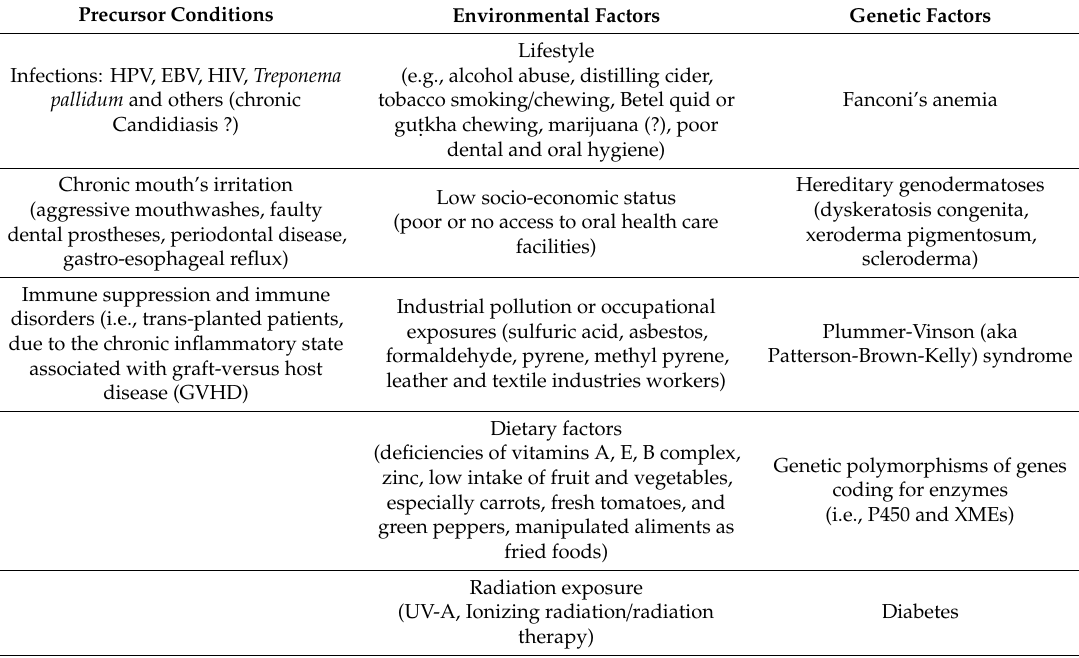
Table 2. Summary of established and presumed risk factors for Oral Cancer.